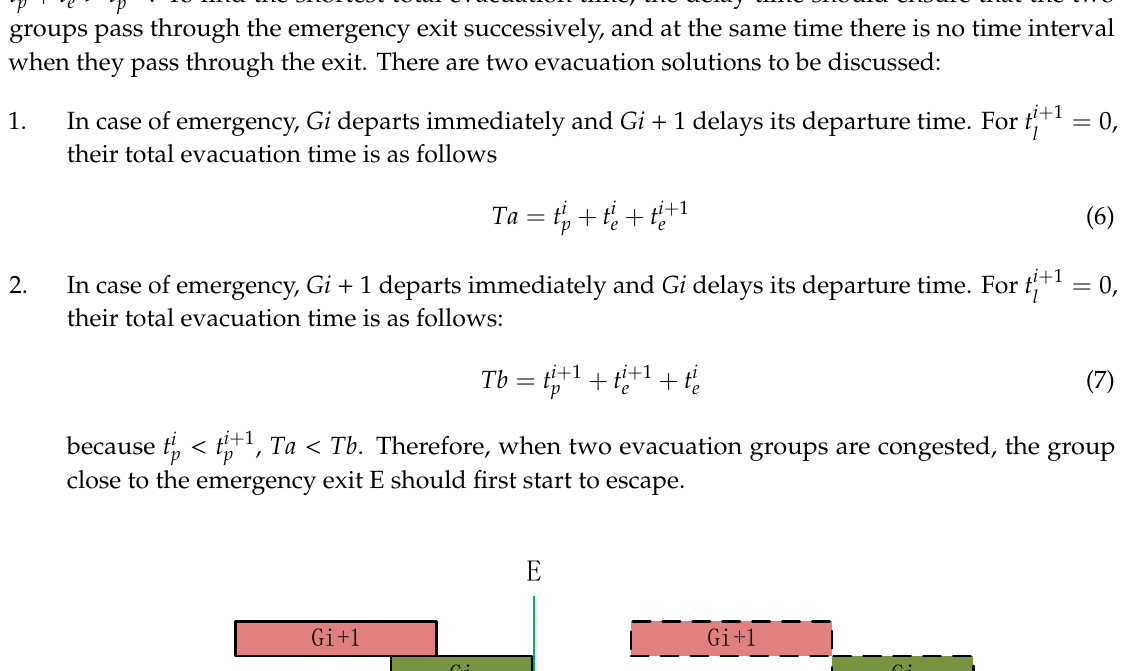
Figure 4. Two groups arrive at the emergency exit at the same time.